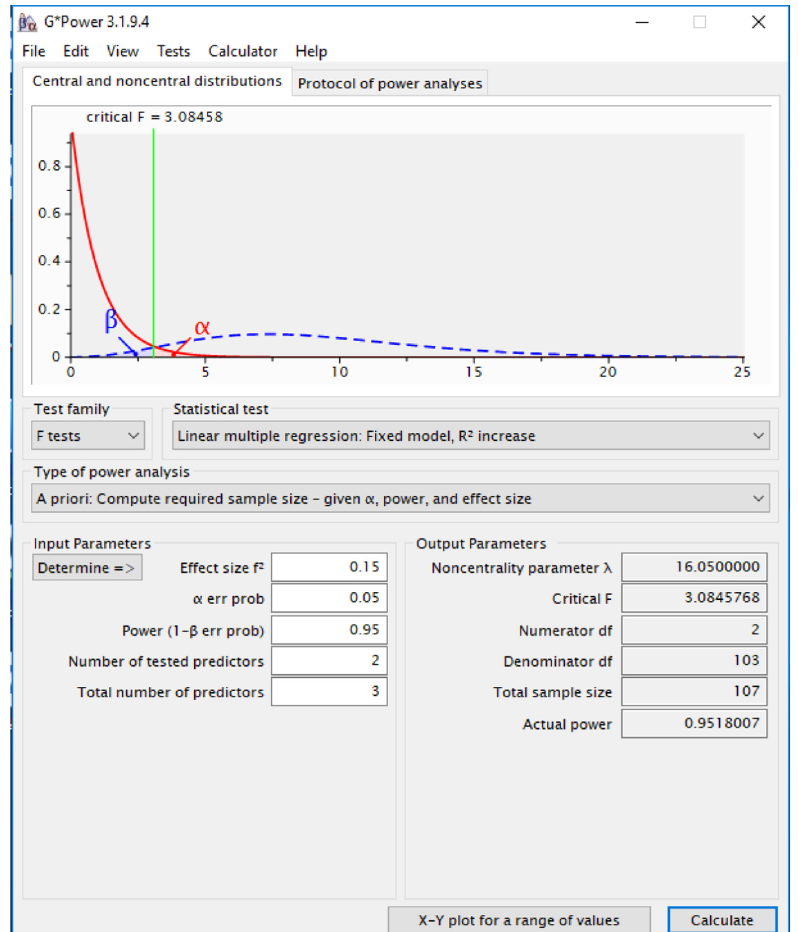
Figure 1. Screen of the